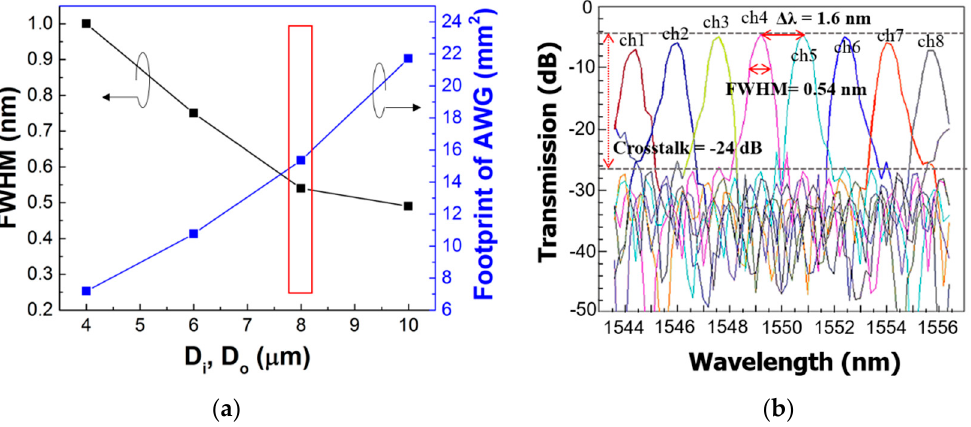
Figure 3. Simulated optical spectrums of AWG: ( a ) trade-off between FWHM and footprint of designed AWGs; ( b ) transmission spectrum for optimized waveguide separation (Di, Do) of 8 μ m.